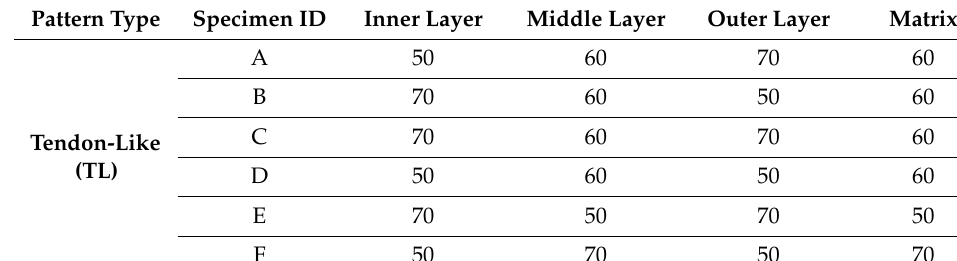
Figure 5. Tendon-Like (TL) pattern arrangement. In a cross-sectional view, the dimensions of each layer are reported. Table 1. Shore A hardness values were assigned for each layer of the Tendon-Like (TL) pattern. The range considered was from 50 (medium-soft) to 70 (hard-soft).